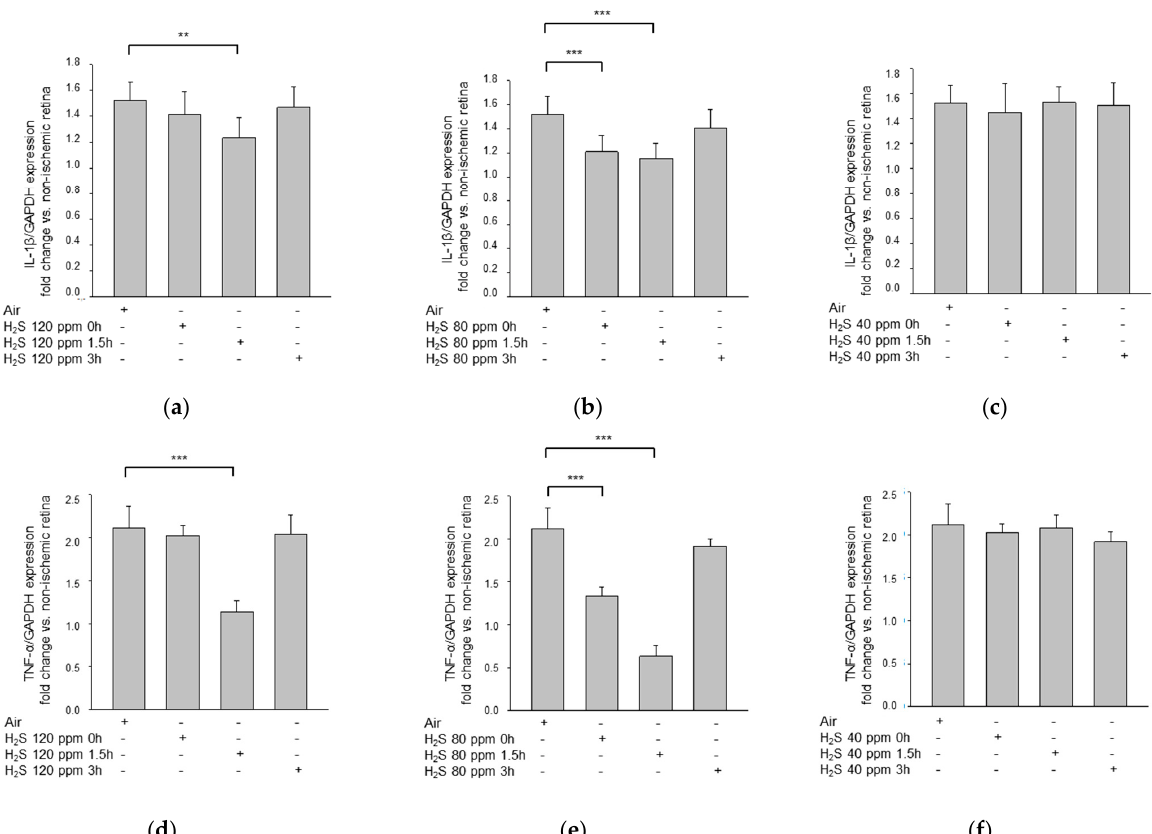
Figure 5. Effect of H 2 S inhalation on the retinal expression of IL-1ß and TNF- α mRNA. ( a – c ) Fold induction of IL-1ß mRNA expression in ischemic retinal tissue compared to GAPDH in relation to the corresponding non-ischemic retinae analyzed by RT-PCR after ( a ) 120 ppm H 2 S inhalation (data are mean ± SD, n = 8; ** = p ≤ 0.01, IRI vs. 120 ppm H 2 S at 1.5 h), ( b ) 80 ppm H 2 S inhalation (data are mean ± SD, n = 8; *** = p < 0.001 IRI vs. IRI + 80 ppm H 2 S at 0 h and vs. IRI + 80 ppm H 2 S at 1.5 h), and ( c ) 40 ppm H 2 S inhalation. ( d – f ) Fold induction of TNF- α mRNA expression in ischemic retinal tissue compared to GAPDH in relation to the corresponding non-ischemic retinae analyzed by RT-PCR after ( d ) 120 ppm H 2 S inhalation (data are mean ± SD, n = 8; *** = p < 0.001, IRI vs. 120 ppm H 2 S at 1.5 h), ( e ) 80 ppm H 2 S inhalation (data are mean ±S D, n = 8; *** = p < 0.001, IRI vs. IRI + 80 ppm H 2 S at 0 h and vs. IRI + 80 ppm H 2 S at 1.5 h), and ( f ) 40 ppm H 2 S inhalation.